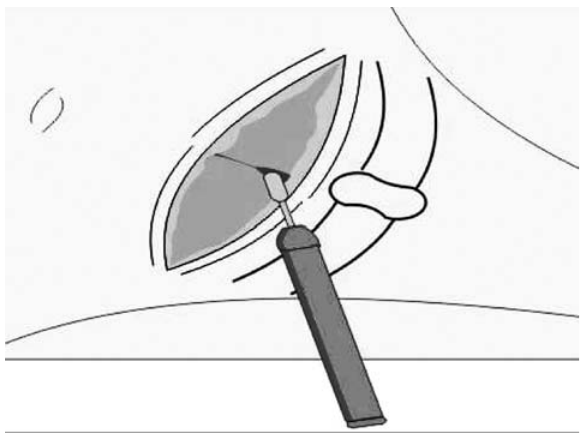
Figure 1 – Modified Pfannenstiel incision. The skin is opened horizontally and the aponeurosis is opened vertically (cruciform incision).